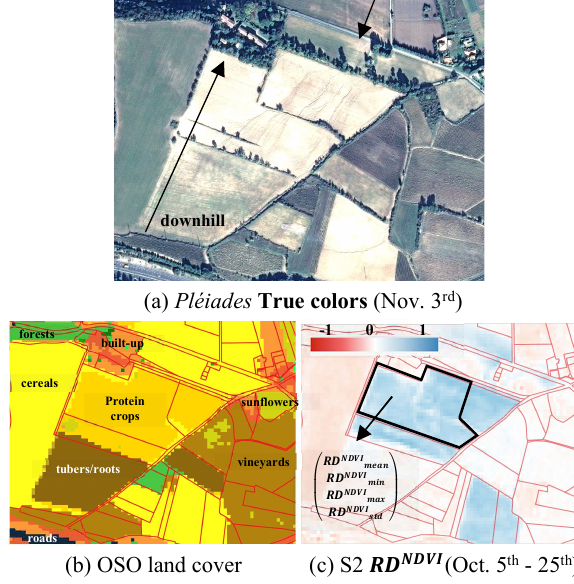
Figure 5 . Erosion lines caused by intense rainwater runoff on agricultural plots. South of Carcassonne. Oct, Nov. 2018.